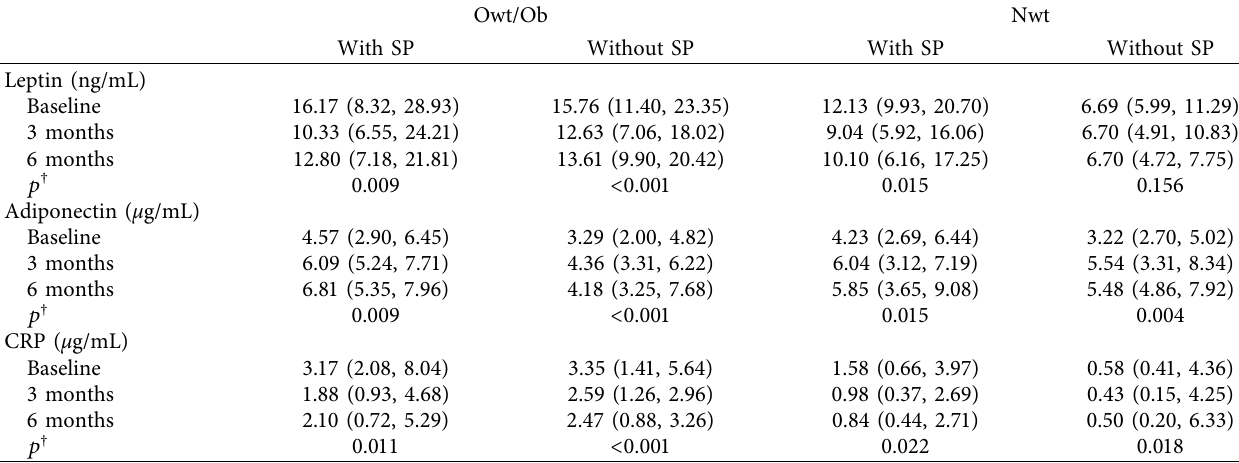
Table 3: Levels of cytokines at baseline, as well as at 3 and 6 months after periodontal treatment, according to BMI and periodontal disease